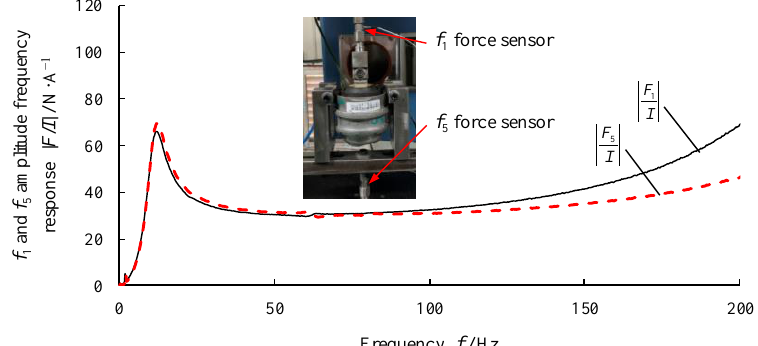
Figure 6. Comparison of experimental results of active characteristics at engine and frame sides of AHM.